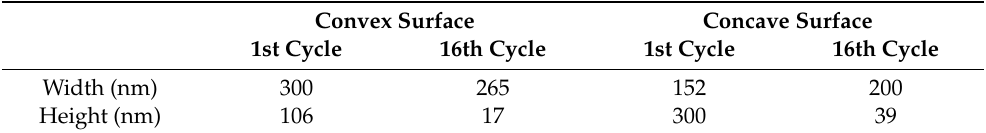
Table 5. Average values of martensite plates according to Figure 12. Convex Surface Concave